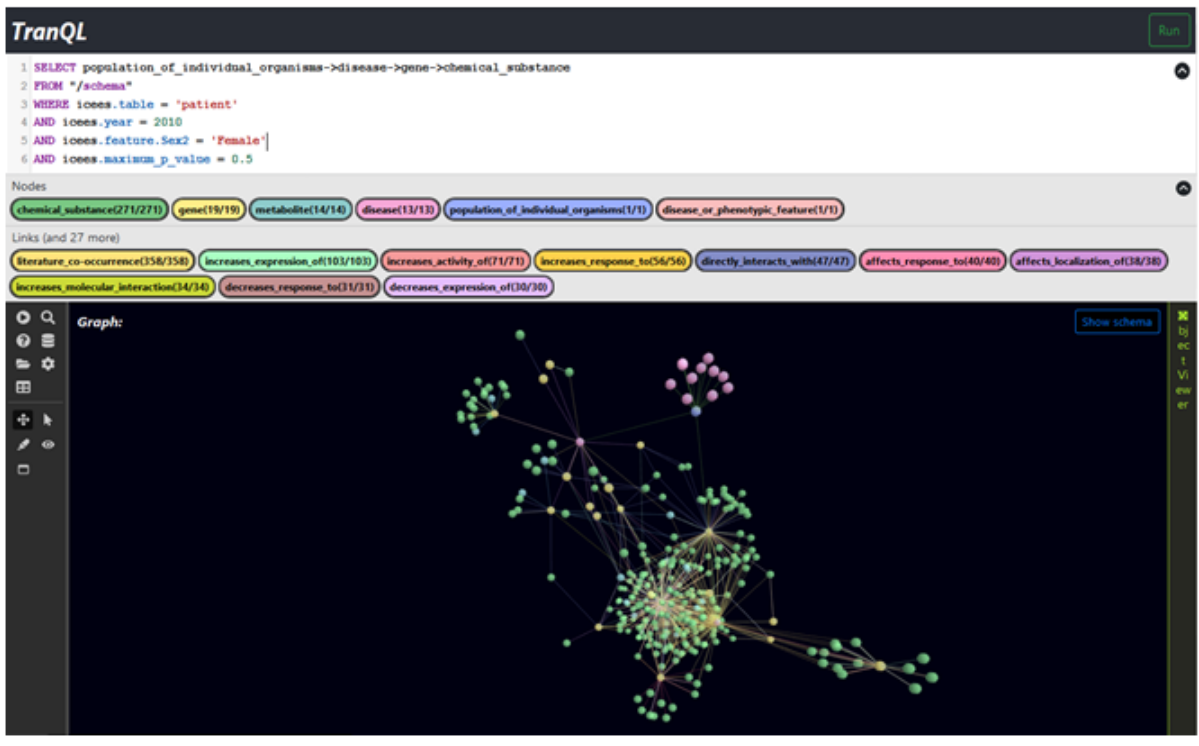
Figure 3. Use Case 1: example TranQL query and answer KG. The TranQL query was manually translated into the TranQL query language from a natural language query that asked, “What diseases are differentially associated with males and females, and what genes and chemical substances are associated with those diseases?”.